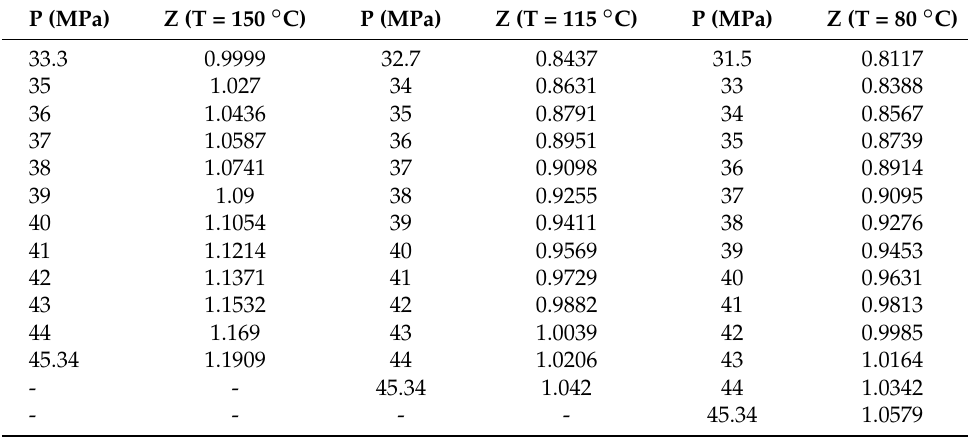
Table A2. Measured compressibility factors of sample 1 in the H2